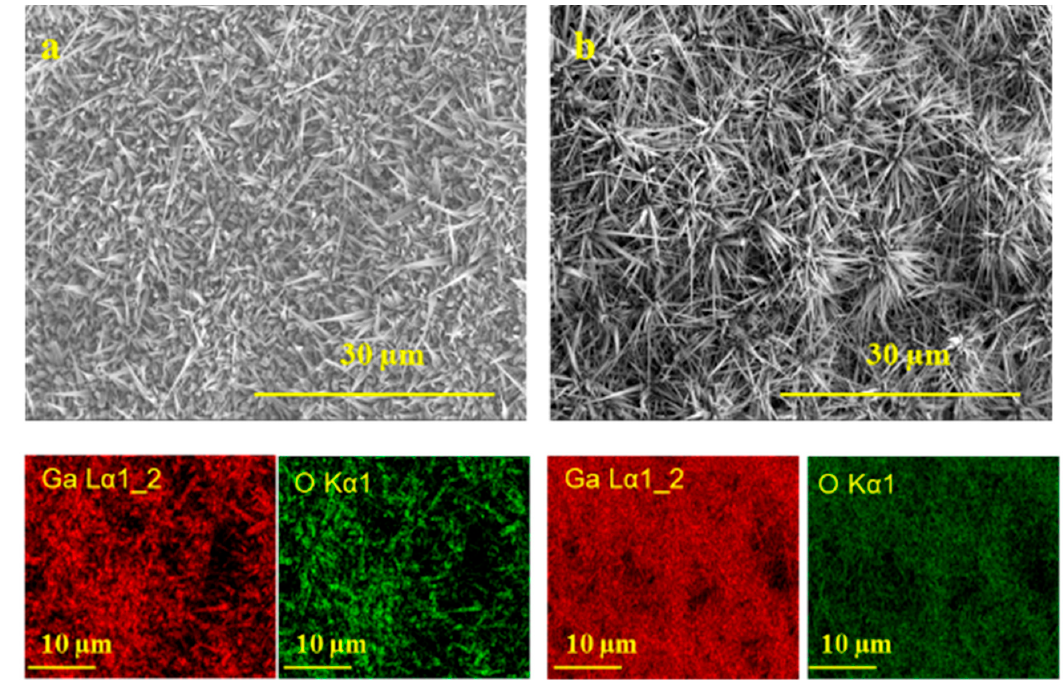
Figure 6. SEM and EDS mapping of grown Ga 2 O 3 nanostructures on quartz without ( a ) and with ( b ) silver catalyst, which were grown at 1000 °C, along with the associated elemental maps for Ga and O. The density and morphology of the Ga 2 O 3 nanowires were enhanced in the presence of the Ag catalyst.